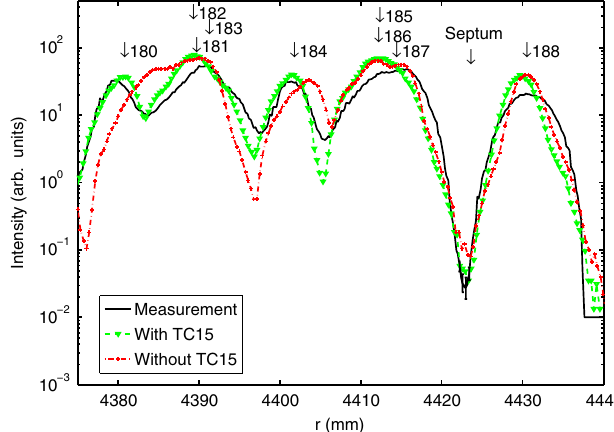
FIG. 7. Radial beam profile with indicated turn numbers at extraction for a 2 mA beam, for a parabolic initial distribution at